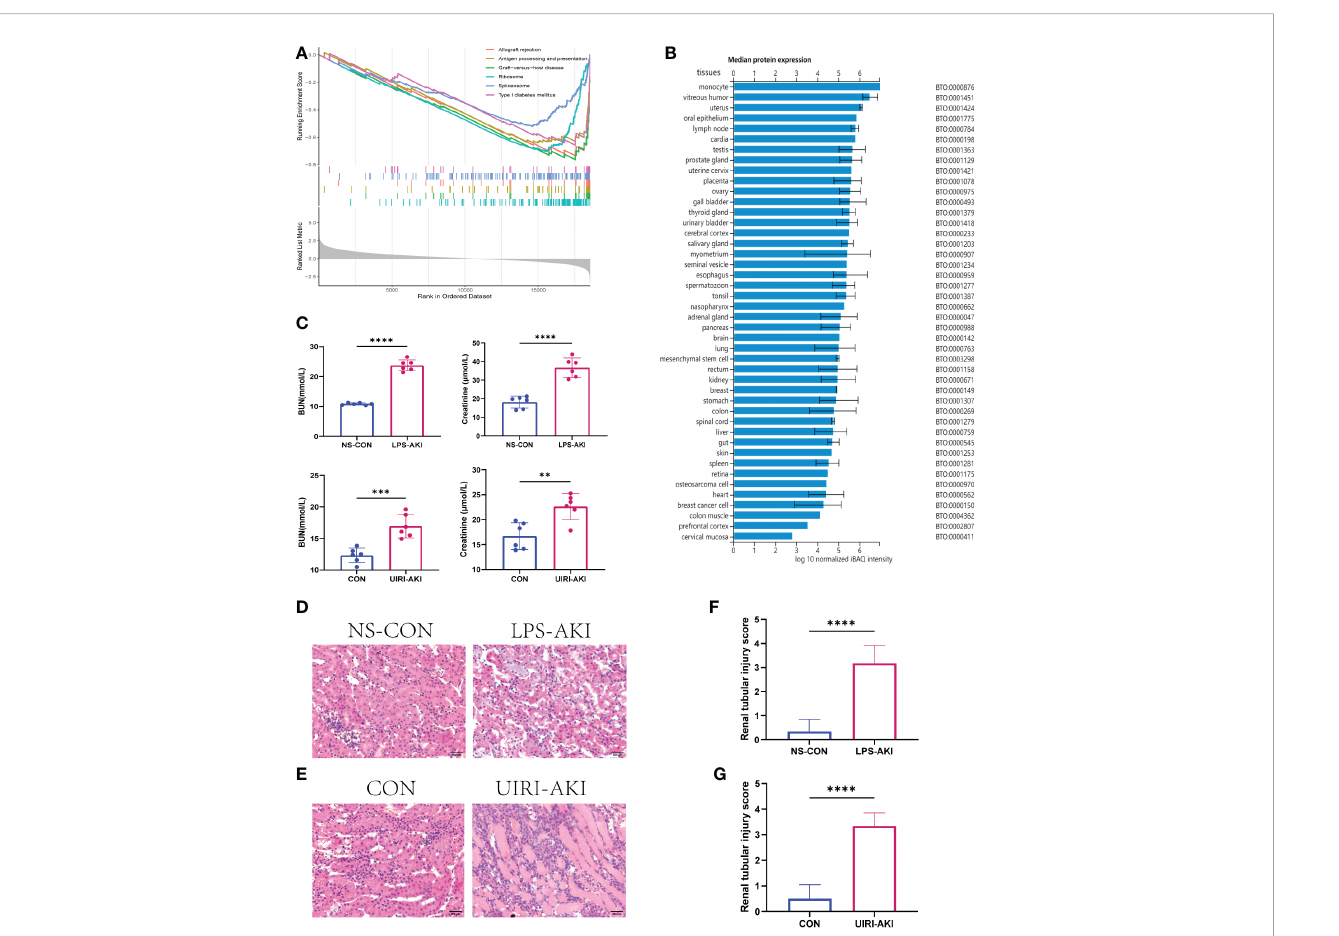
FIGURE 6 (A) GSEA of AFM. The fi rst part shows the enrichment fraction broken line of six pathways, the line in the middle part corresponds to the genes of each diagram, and the third part shows the rank value distribution map of all genes. (B) The median protein expression of tissues or cells in the ProteomicsDB. (C) BUN and SCr values in two AKI mouse models (LPS-AKI; UIRI-AKI). (D, E) HE staining showed deterioration of the histological features of the renal cortex in two AKI models (LPS-AKI; UIRI-AKI). (F, G) The renal tubular injury score of two AKI moudules. **p < 0.01, ***p < 0.001, ****p < 0.0001.